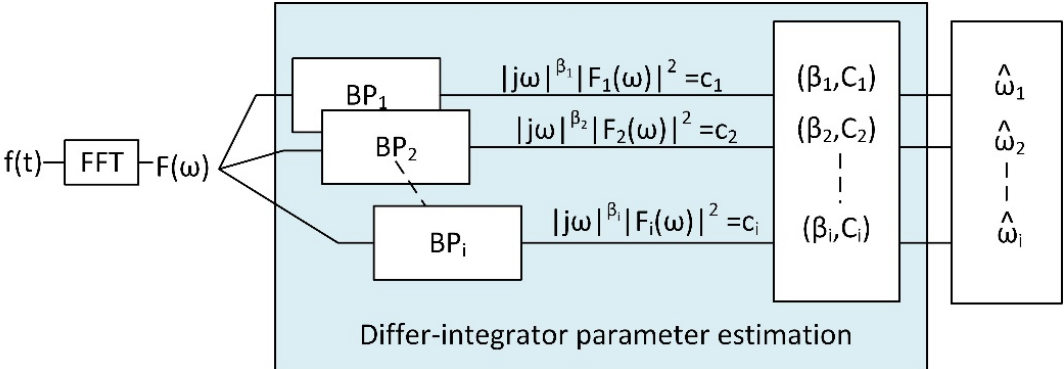
Figure 1. Proposed instantaneous frequency estimation with fractional differential equation models around spectrogram peak frequencies.